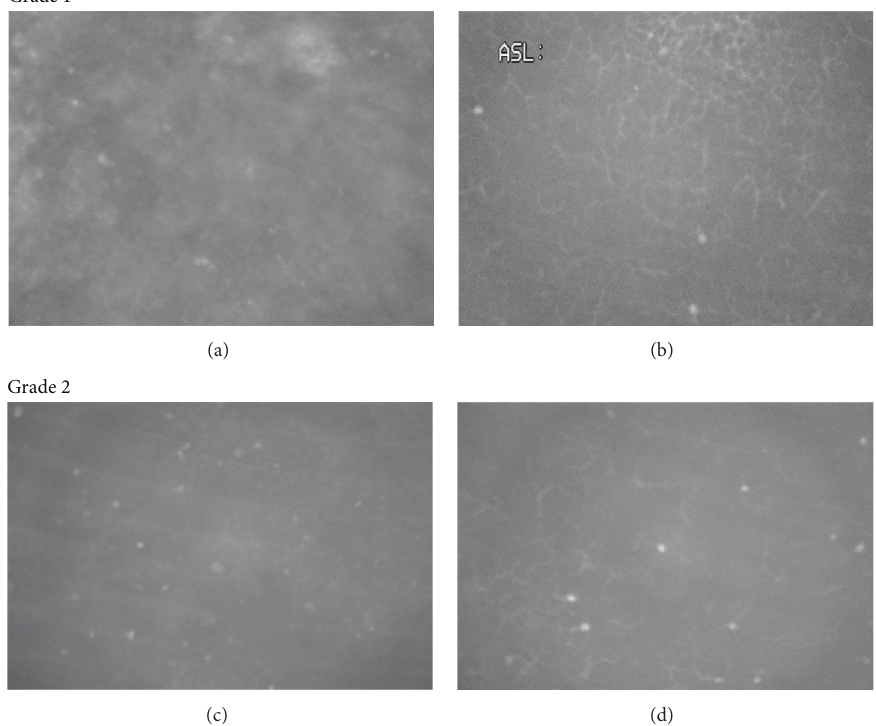
Figure 1: Severity grade 1 ((a)and (b)):few cysts, confined to epithelium (notevariable sizeof Acanthamoeba organisms in (a) and Langerhans cells in (b)), confined to small area of the cornea. Severity grade 2 ((c) and (d)): more numerous cysts with clearer morphology, limited to epithelium, confined to small area of the